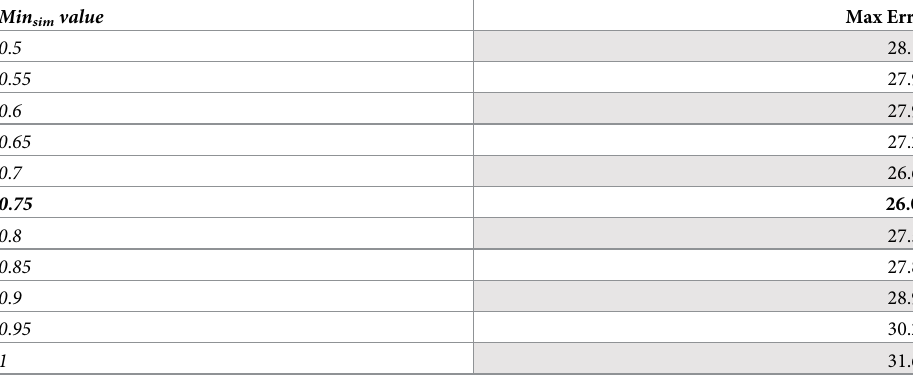
Table 2. Results of the preliminary experiment for Min sim